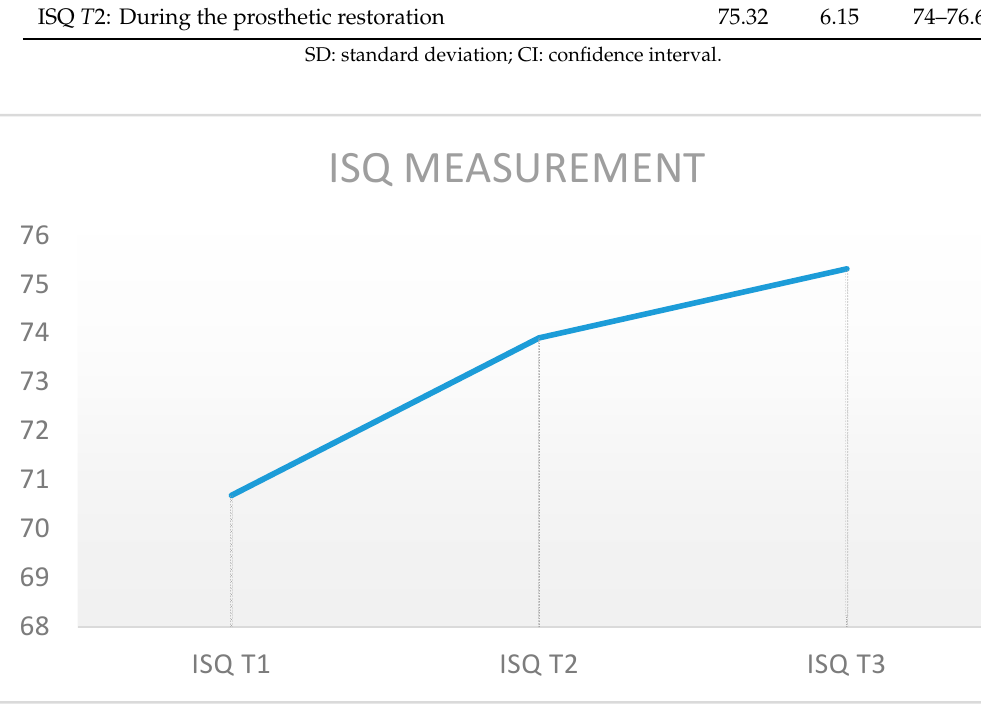
Figure 7. ISQ values measured at the three occasions.